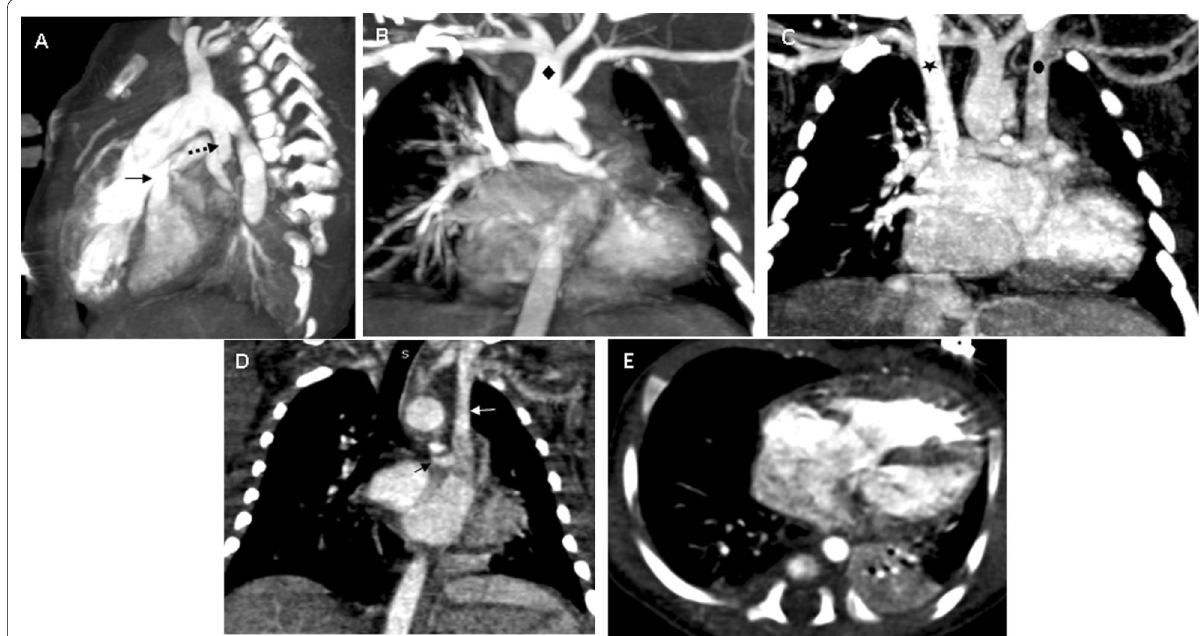
Fig. 5 A 30-day-old male infant with CHD for preoperative assessment. A CT sagittal MIP revealed DORV with overriding aorta, subaortic VSD (arrow in A ), pulmonary stenosis and large tortuous PDA (dotted arrow) connecting the aortic arch and left pulmonary artery. B Coronal MIP showing aortic arch giving origin to left subclavian artery and arterial trunk (diamond) that bifurcates into left CCA & brachiocephalic artery. C Coronal MIP showing Rt SVC (*). D Coronal MPR showing a long vascular channel (circle) in C and (white arrow) in D on the left side of the aorta, its upper end draining into left subclavian/left innominate vein, representing persistent left SVC, with the left inferior pulmonary vein (black arrow) is seen draining into this vascular channel. E Axial images showing RV hypertrophy and Lt basal consolidation